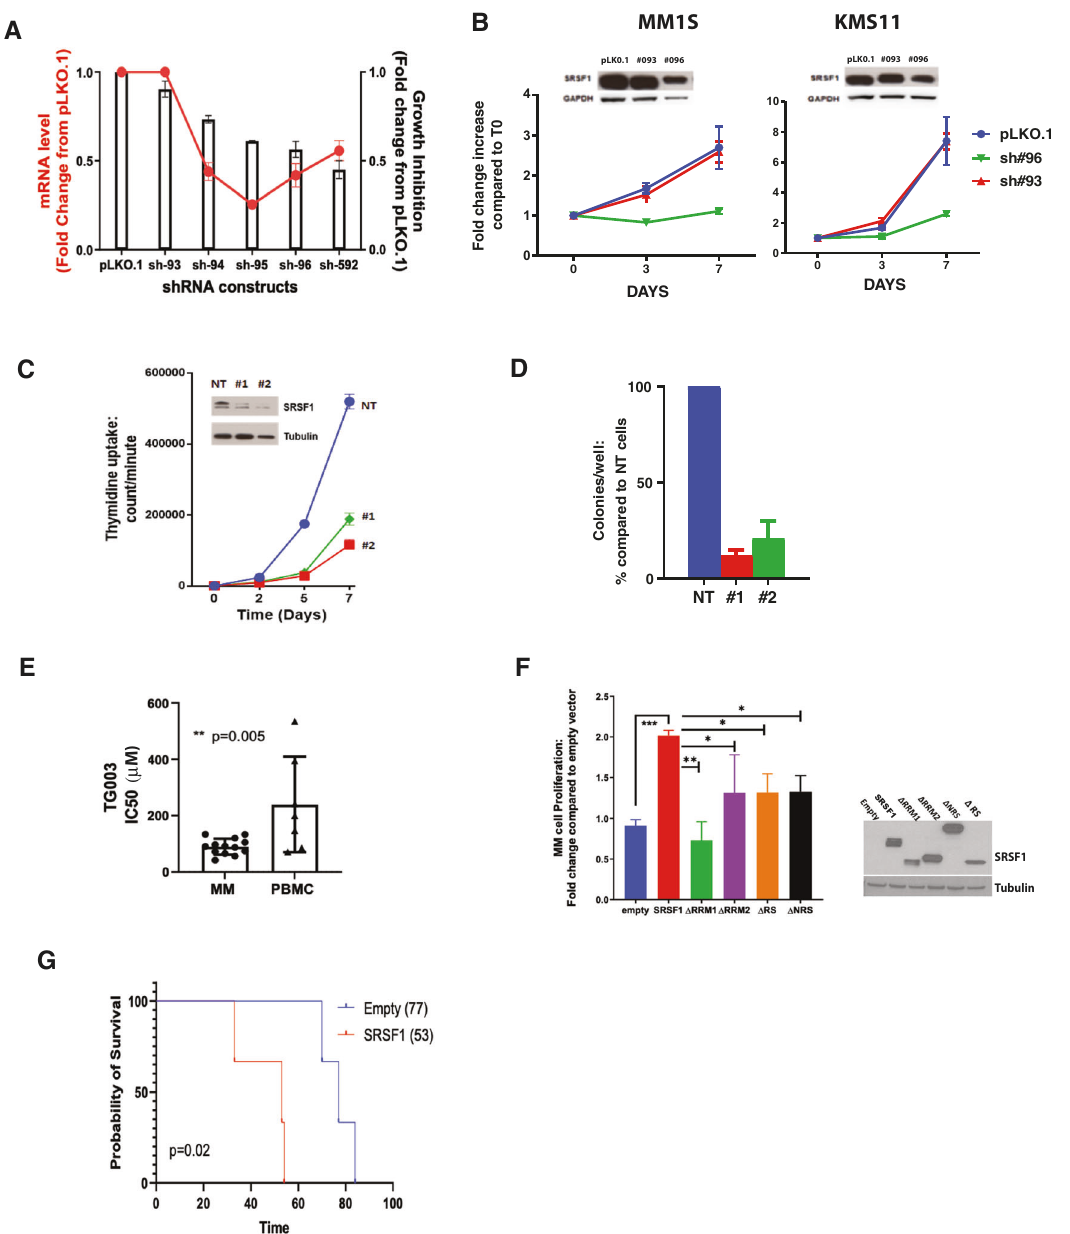
Fig. 3 SRSF1 expression impacts MM cell growth and viability. A Genetic depletion of SRSF1 was achieved using four different shRNAs containing the target sequence or scrambled control in MM1S ( x -axis). MM1S cells were infected with either scrambled (pLKO.1) or 4 SRSF1- targeted shRNAs and selected with puromycin for 72 h. qPCR analysis (right panel) was performed to con fi rm decreased SRSF1 mRNA levels (red line, right y -axis) in cells expressing SRSF1 shRNAs compared to scrambled cells (red line). Transduced cells were analyzed for effect on cell growth by 3(H) thymidine uptake and presented as fold change from cells infected with pLKO.1 (left y -axis and bar plots). Data are shown as the mean values ± s.d. of triplicates. B SRSF1 protein levels and cell proliferation were evaluated three days from puromycin selection by WB and CTG. Cellular proliferation is presented as the growth rate increase compared to t = 0. Reduced expression of SRSF1 is accompanied by a reduction of cell growth rate compared to control cells. C CRISPR/Cas9 knockdown studies were performed using transEDIT lentiviral gRNA plus Cas9 expression vectors in the KMS11 cell line. Cell growth was evaluated by 3H-thymidine uptake ( y axis) over time ( x axis). D CRISPR/ Cas9 knockdown studies were performed using transEDIT lentiviral gRNA plus Cas9 expression vectors in the KMS11 cell line. Colony formation was measured in semi-solid, methylcellulose media. Graphs depict average colony numbers (mean ± SD) from control (NT) and KO MM cells in methylcellulose medium on day 21. E A panel of 13 MM cell lines (circles in left bar plot) and PHA-activated PBMC from seven healthy donors (triangles) were tested with different concentrations of TG003. IC50 analysis and a non-parametric t-test were performed. Data are shown as the mean value ± SD. F KMS20 MM cells were stably transduced with retroviruses expressing empty vector or T7-tagged SRSF1 mutants ( x - axis). These cells were analyzed by western blotting with an anti-T7 antibody (right panel) to con fi rm transduction ef fi ciency. Cell proliferation was evaluated after seven days of culture and represented as fold change from an empty control ( y -axis). G SCID mice were injected with empty or SRSF1-expressing KMS20 cells ( n = 3/cohort) and evaluated for overall survival. Log-rank Mantel-Cox test was utilized to assess statistical signi fi cance ( p =